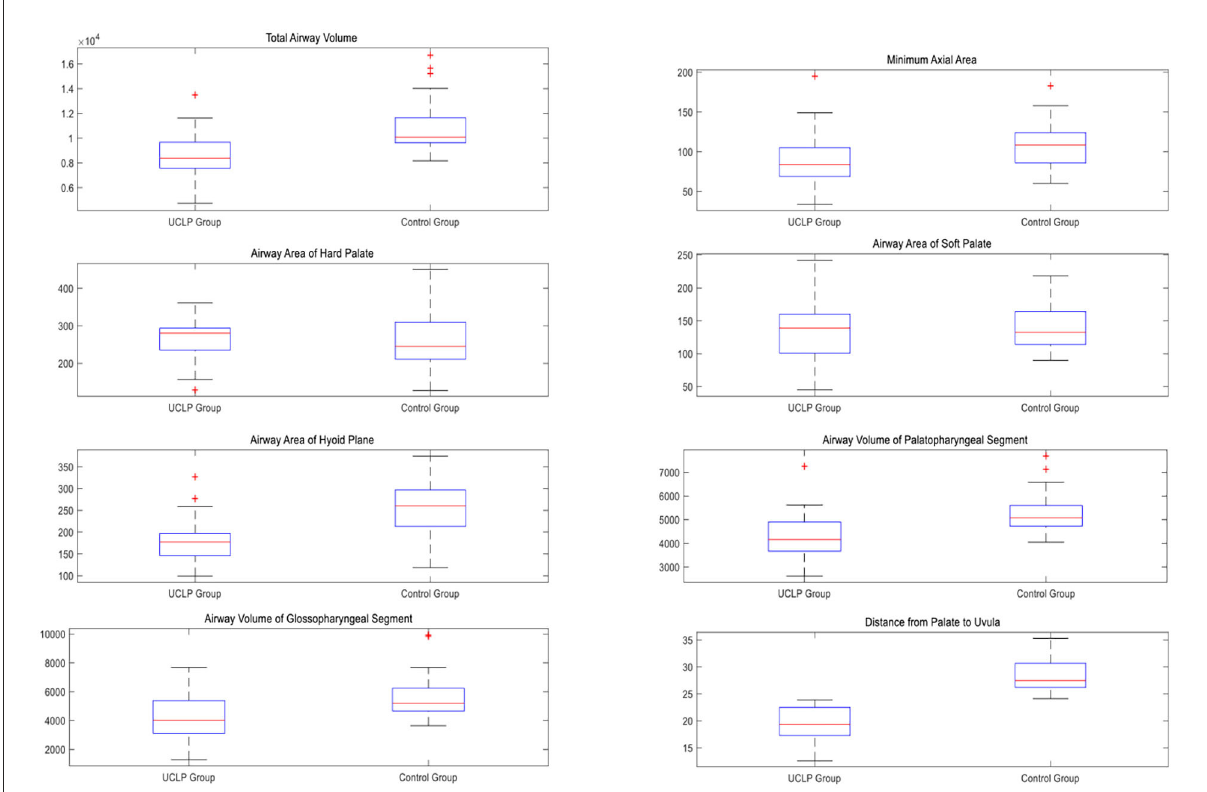
FIGURE5 The dependent variables in the unilateral complete cleft lip and palate group and control